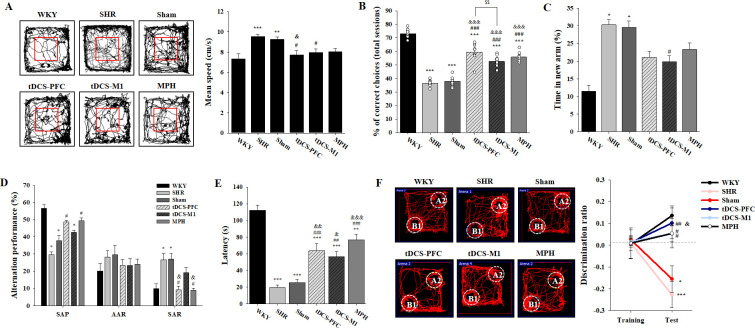
Effects of HD-tDCS application on cognitive behaviors in a rat model of ADHD.(A) Performance and mean speed on the open-field test. Hyperactivity in the open-field test was significantly reduced in the tDCS-PFC group compared with the sham group (n = 8). (B) A DNMTP of the T-maze results, total % of correct choices for 10 sessions. The % correct choices were significantly higher in all HD-tDCS and MPH-treated groups compared to the sham group (n = 7). (C) Modified Y-maze results, % of time in new arm. The time in the new arm was significantly decreased in the tDCS-M1 group compared with the SHR group (n = 8). (D) Y-maze spontaneous alternation task, % alternation performance of SAP, AAR, and SAR. SAR was significantly lower in the tDCS-PFC and MPH groups compared with the sham group (n = 7). (E) Passive avoidance test, latency. HD-tDCS and MPH-treated groups showed significantly higher latency compared to the sham group (n = 6). (F) Object-place recognition test, representative examples of movement path and discrimination ratio. The tDCS-PFC group showed a marked increase in time spent exploring the novel placed object compared to the sham group (n = 8). SAP; spontaneous alternation performance, AAR; alternate arm return. Data are presented as mean ± SEM. *p<0.05, **p<0.01, and ***p<0.001 vs. WKY; #p<0.05, ##p<0.01, and ###p<0.001 vs. SHR; &p<0.05, &&p<0.01, and &&&p<0.001 vs. sham; $$p<0.01 vs. tDCS-PFC.Figure 1—source data 1.Source files for behavior tests.This zip archive contains all source data on the cognitive behaviors shown in Figure 1.